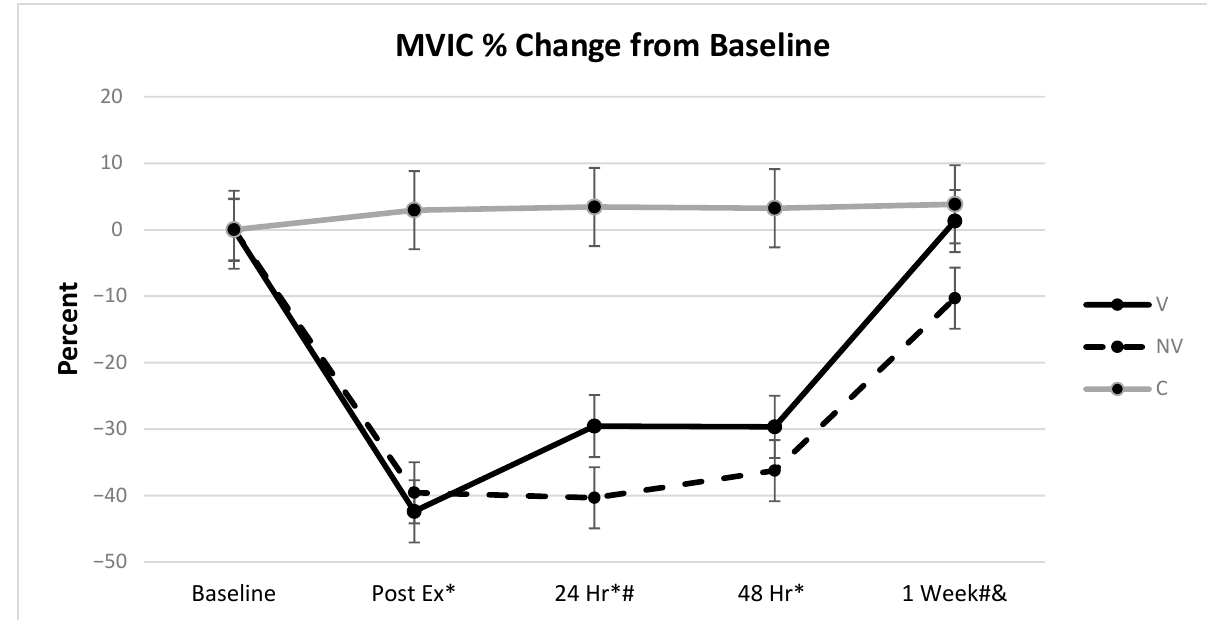
Figure 5. Change in maximal voluntary isometric strength. * = significantly different from control, # = V significantly different from NV, & = NV significantly different from control (bars represent the 95% confidence interval values).